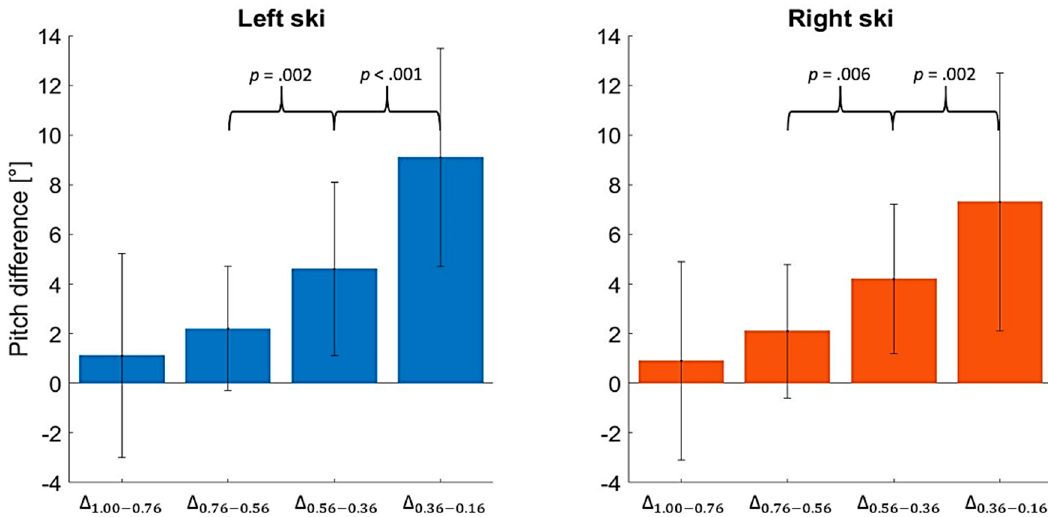
Figure 7. Difference Δ of the pitch movement between t 1.00 – t 0.76 , t 0.76 – t 0.56 , t 0.56 – t 0.36 , and t 0.36 – t 0.16 for the 30 collected jumps for the left and the right ski. The p -values indicate the statistical difference between the variations of contiguous ranges.